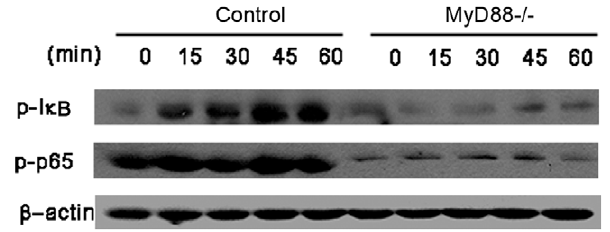
Figure 6. MPSSS activated MDSCs through a MyD88-depen- dent NF- k B signal pathway. Purified MDSCs from control C57BL/6 and MyD88 2 / 2 tumor-bearing mice were stimulated with MPSSS for different times as indicated. Levels of P-p65, and P-I k B in total cell lysates were determined by Western blotting. The expression of b -actin served as a control. The image shown was representative for 3 independent experiments.